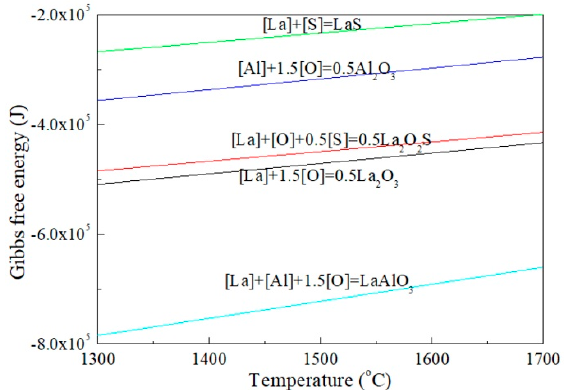
Figure 7. Gibbs free energy of La-related reactions per lanthanum or aluminum in molten steel.